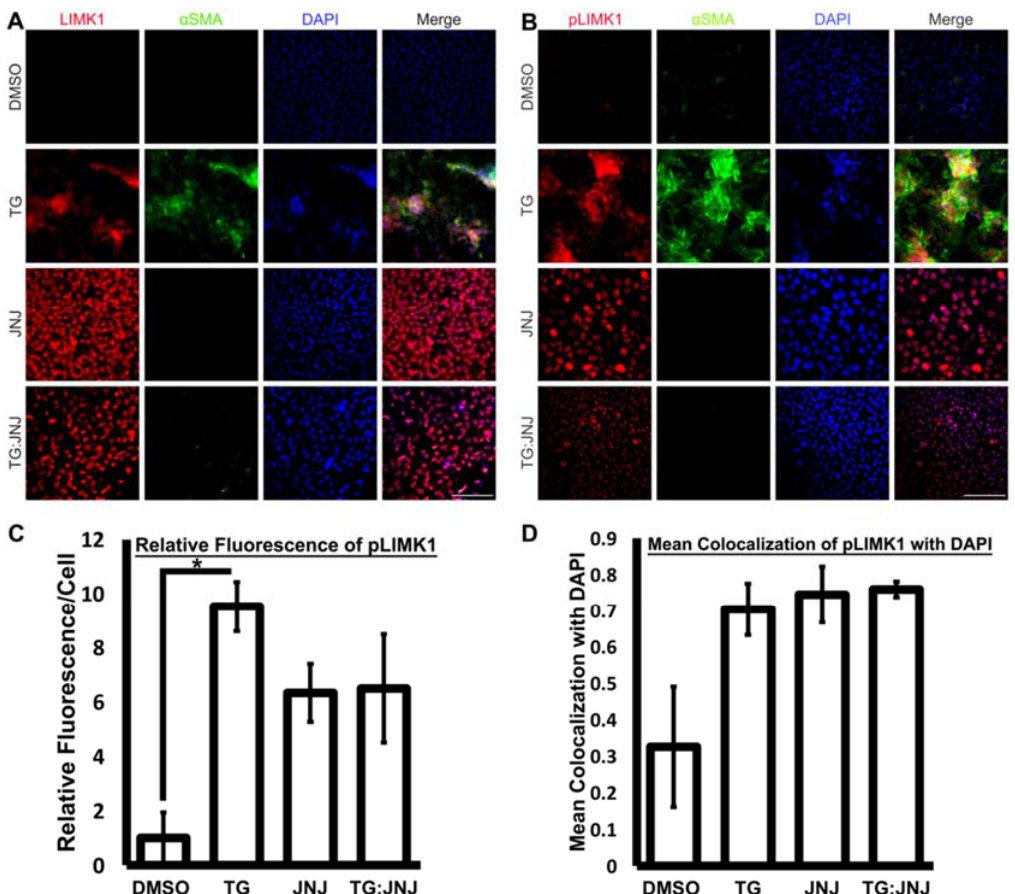
Figure 7. Localization of overall lim-domain kinase-1(LIMK1) and phosphorylated LIMK1 at Thr508 (pLIMK1) upon MMP9 inhibition. Rat LEC explants were treated with <5% DMSO, with 6ng/mL TGF- β for 48 h (TG), with 20 µM JNJ0966 (JNJ) for 48 h, or pretreated with 20 µM JNJ0966 for 2 h followed by 6ng TGF- β for 48 h (TG:JNJ) ( n = 3 independent experiments, where n ≥ 3 LECs per treatment were used for each experiment). Paraformaldehyde (PFA) fixed explants were stained for LIMK1 ( A ), pLIMK1 ( B ) and α SMA, and mounted with DAPI to visualize the nuclei. Images were acquired using Leica DM6 fluorescence microscope at 40×. Scale bar, 100 µm. ( C ) Graph showing mean pLIMK1 fluorescence per cell relative to LECs treated with DMSO. Fluorescence per cell was acquired using Image J ( n ≥ 3 LECs per treatment). Error bars indicate ± SEM of the relative mean fluorescence (One-Way ANOVA shows * p < 0.05; Tukey’s Test shows * p < 0.05 between DMSO control and TG LECs). ( D ) Graph showing Manders’ coefficient for fraction of pLIMK1 colocalizing with DAPI ( n ≥ 3 LECs per treatment). Colocalization was detected using Image J. Error bars indicate ± SEM (One-Way ANOVA shows * p < 0.05; Tukey’s Test indicates no significance between the four treatment groups).